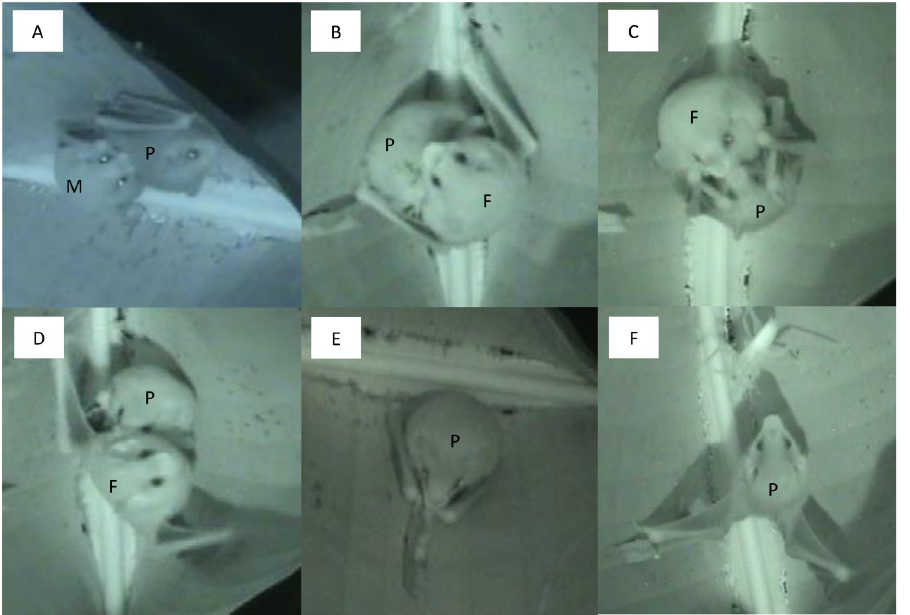
Fig 2. Social behaviours of E . alba . A: Fur chewing behaviour. The male (M) is chewing/licking the back of the pup (P). B: Nursing. The pup (P) is attached to the nipple of the female (F). C: Licking. The pup (P) is licking the mouth of the female (F) to solicit nursing. D: Twitching. The female (F) is shaking the pup (P) off after nursing. E: Play. The pup (P) is playing with a torn leaf piece inside the tent. F: Startle response. The pup (P) shows the typical wing posture when frightened, in this case by a grasshopper that has wandered into the tent. For detailed descriptions of the behaviours see Table 1.